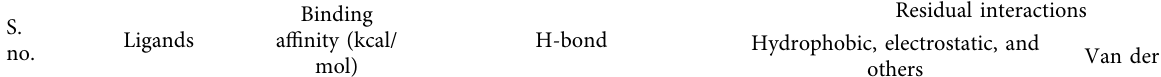
Table 3: Molecular docking results of synthesized compounds against S. aureus gyrase (PDB ID: